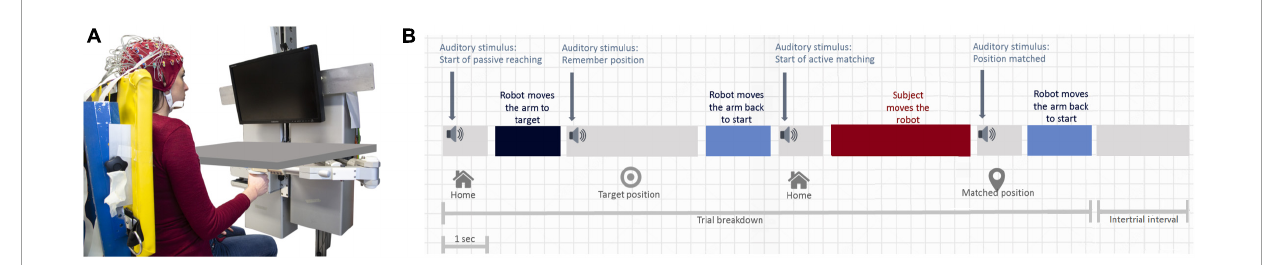
FIGURE1 Experimental setup and protocol. (A) Robotic device with a board occluding vision of the arm. (B) Timeline of an experimental trial, consisting of passive matching, holding time, the first passive return, active matching, and final passive return. The duration of the active matching phase corresponds to the average duration employed by our sample of subjects (1.2 s from onset to offset + 2 s after the offset to let the subjects end completely his movement). The duration of the passive displacement toward each target was 1 s.